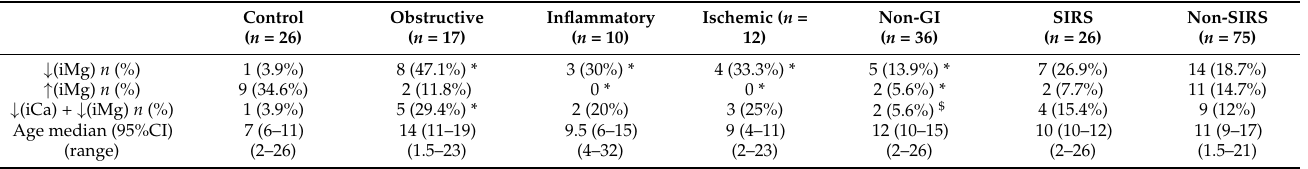
Age and proportion of horses with hypomagnesemia ( ↓ (iMg)), hypermagnesemia ( ↑ (iMg)) and simultaneous hypomagnesemia and hypocalcemia ( ↓ (iCa)) according to diagnostic and SIRS